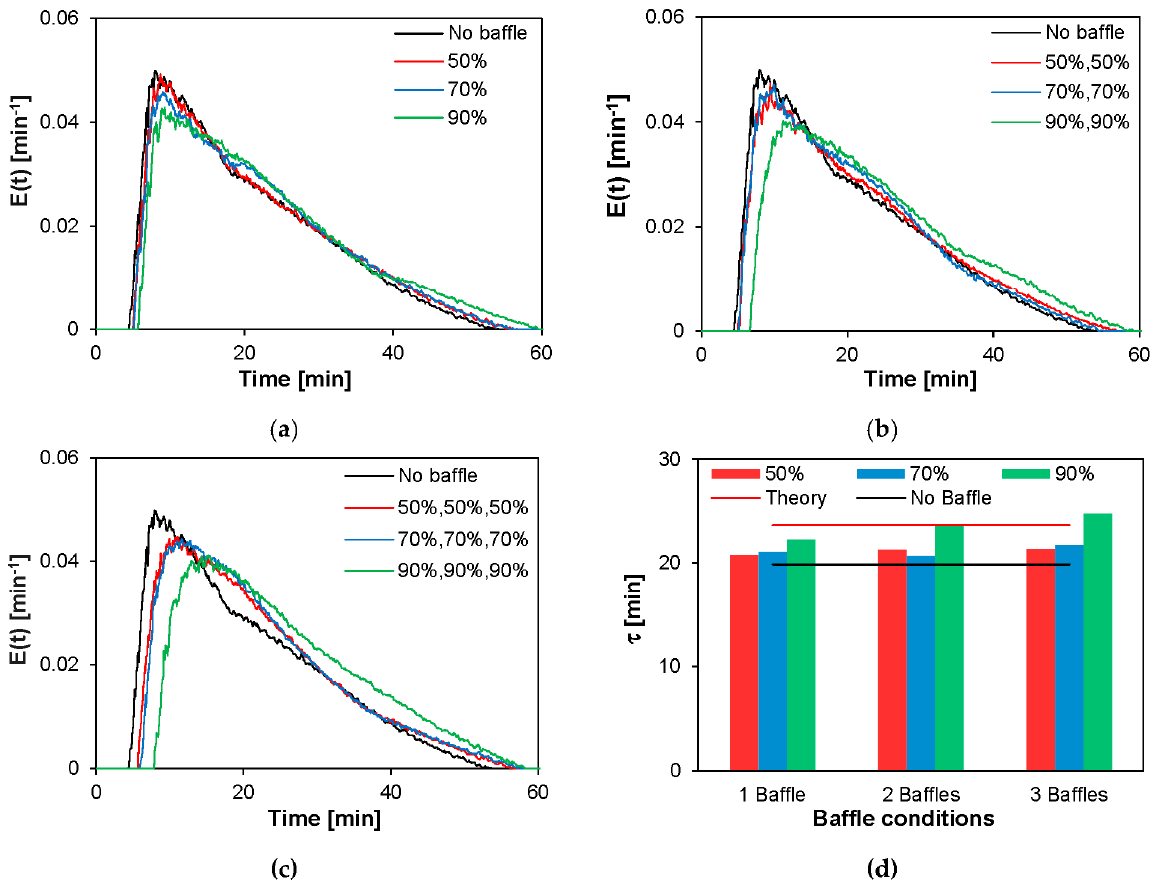
Figure 9. E (t) curve under a flow rate of 6 L/min measured at the outlet port of IECS using different compartment baffle conditions: ( a ) one baffle, ( b ) two baffles, ( c ) three baffles with different length percentages compared to EC width, and ( d ) their mean time distributions comparison.